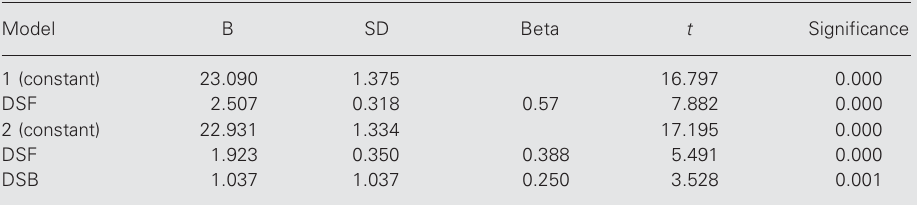
Table 8. Partial correlation coefficients.